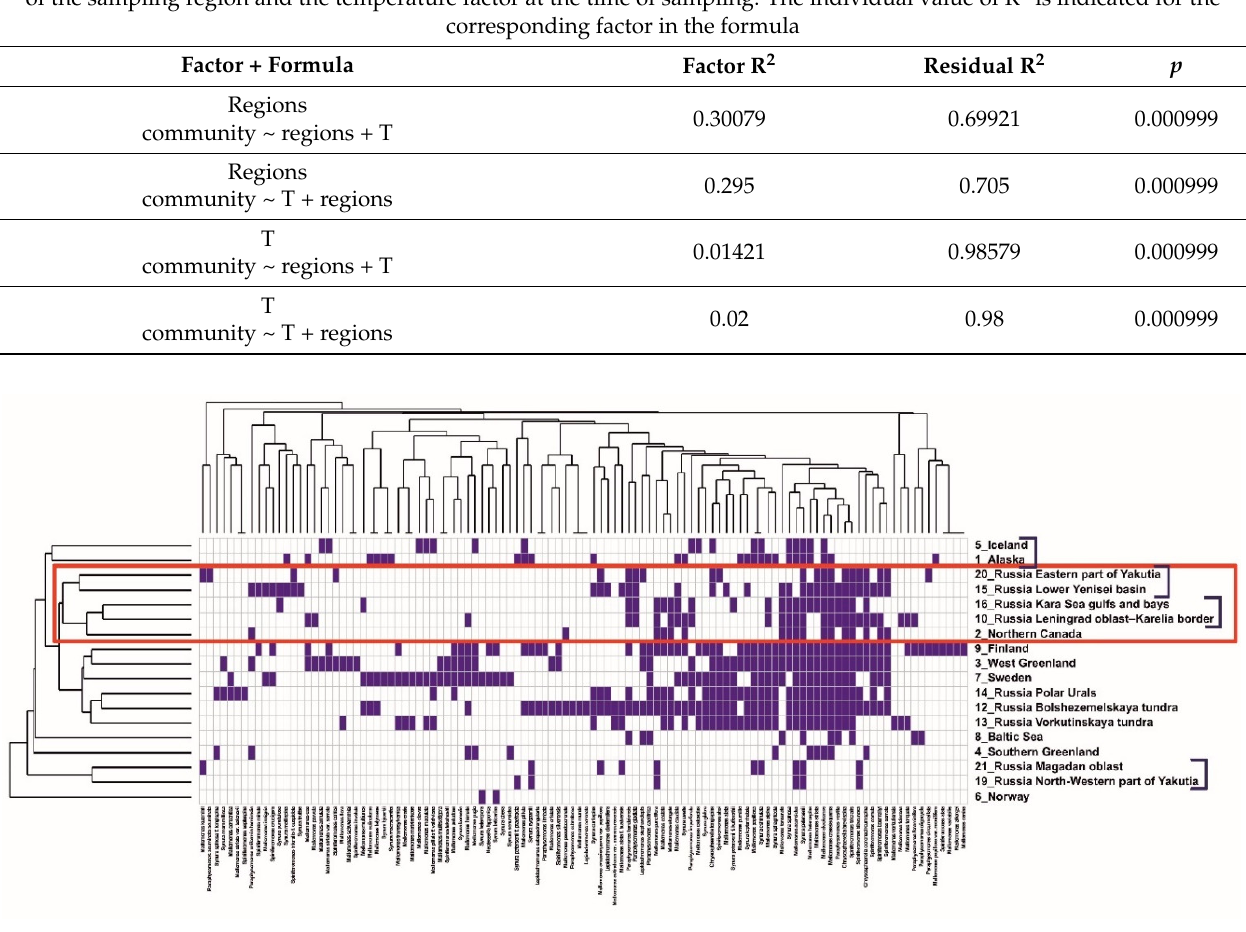
Figure 5. Heat map of species representation status in the regions. Painted boxes at the intersection of rows and columns indicate that the species occurs in at least one water body in the region. Rows and columns of the heat map are ordered according to clustering results. Left and upper parts show dendrograms of clustering of regions and species by similarity of representation status.